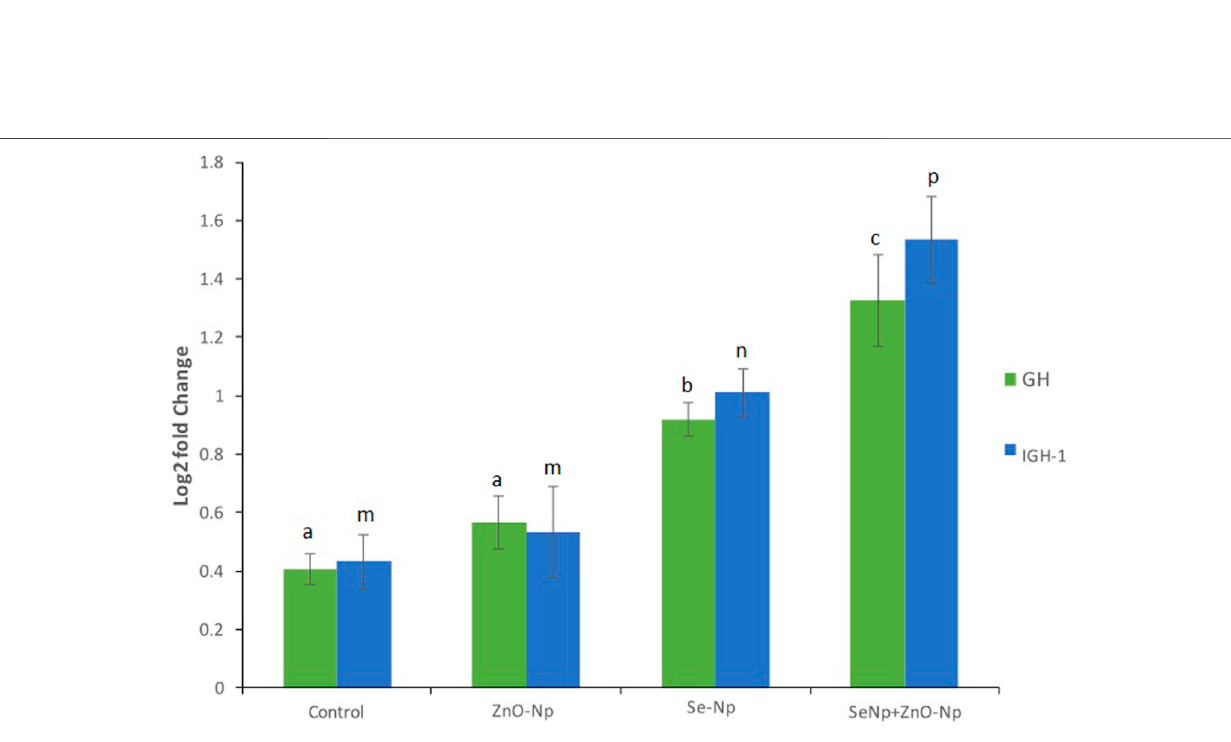
Frontiers in Bioengineering and Biotechnology |